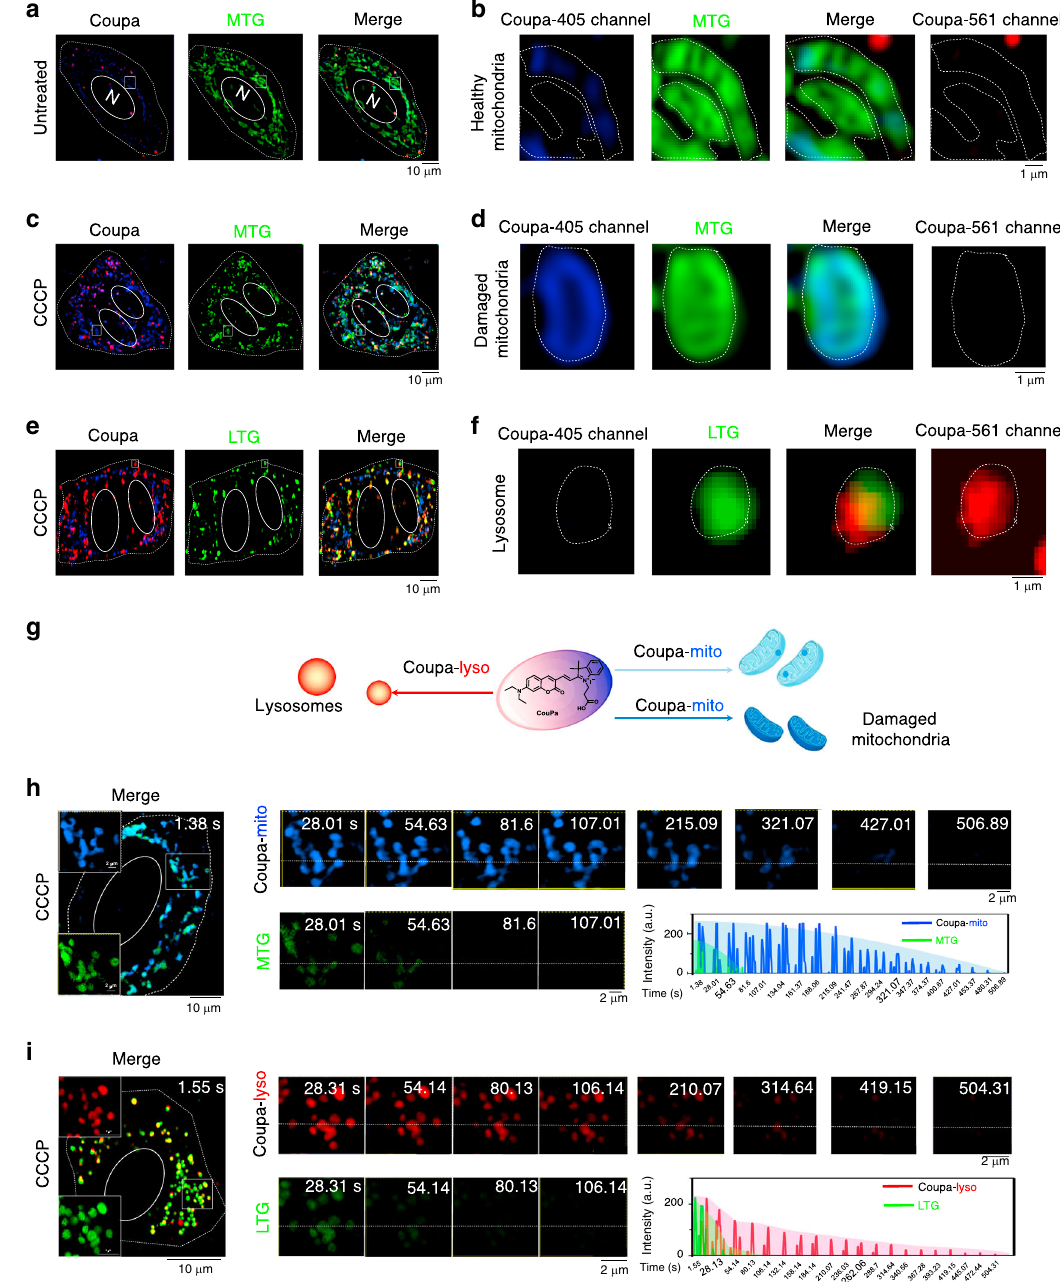
Fig. 2 Characterization of Coupa in living cells via SIM imaging. a , c Mitochondria co-stained with Coupa (405 nm excitation) and MTG (488 nm excitation) in untreated ( a ) and CCCP-treated HeLa cells ( c ). b , d Zoom-in images of white rectangles in a and c ; e CCCP-treated HeLa cells co-stained with Coupa (561 nm excitation) and LTG (488 nm excitation); f Zoom-in images of white rectangle in e . g Schematic representation of Coupa staining mitochondria (Coupa-mito) and lysosomes (Coupa-lyso) simultaneously in living cells; photobleaching of Coupa-mito and MTG ( h ) and Coupa-lyso and LTG ( i ) upon continuous irradiation by 561-nm and 488-nm lasers. White dotted lines indicate region of interest for fl uorescence measurement. The time- dependent fl uorescence intensity was shown in the lower right panel. MTG channel: Ex, 488 nm, Em, 500 – 550nm; LTG channel: Ex, 488 nm, Em, 500 – 550 nm; Coupa-lyso channel: Ex, 561 nm, Em, 570 – 640 nm, and Coupa-mito channel: Ex, 405 nm, Em, 420 – 495